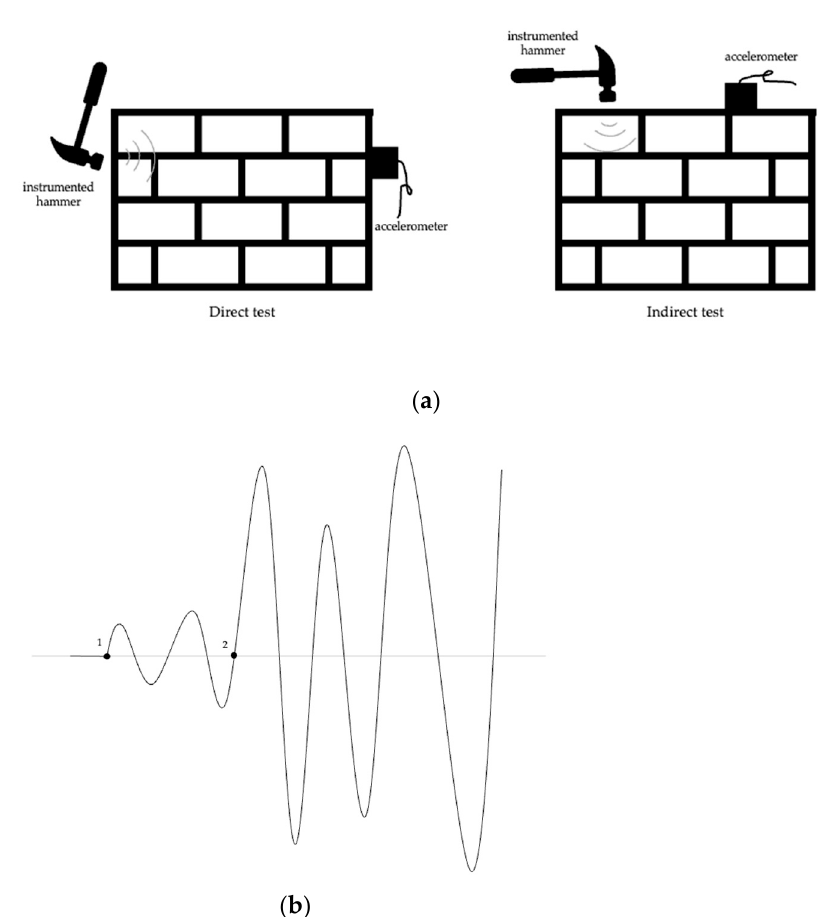
Figure 1. ( a ) Sonic tests configuration and ( b ) wave identification scheme.